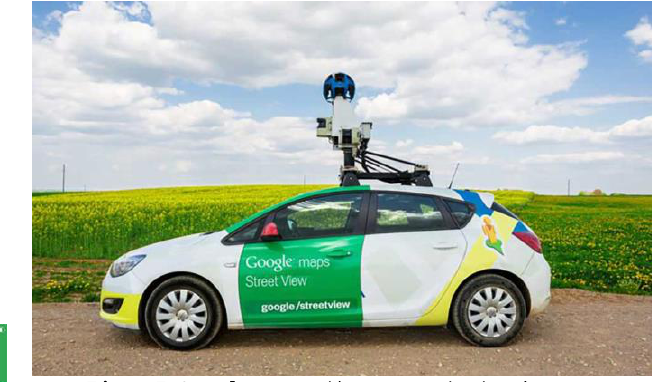
Figure 7. Google car provides panoramic view data.